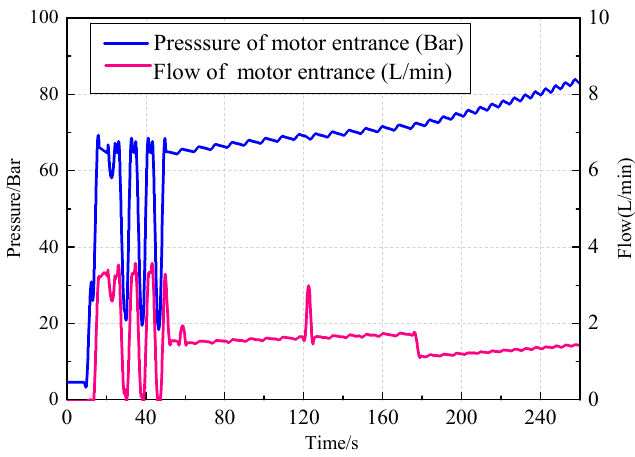
Figure 16. Pressure curves of active hydraulic cylinder and check valve.